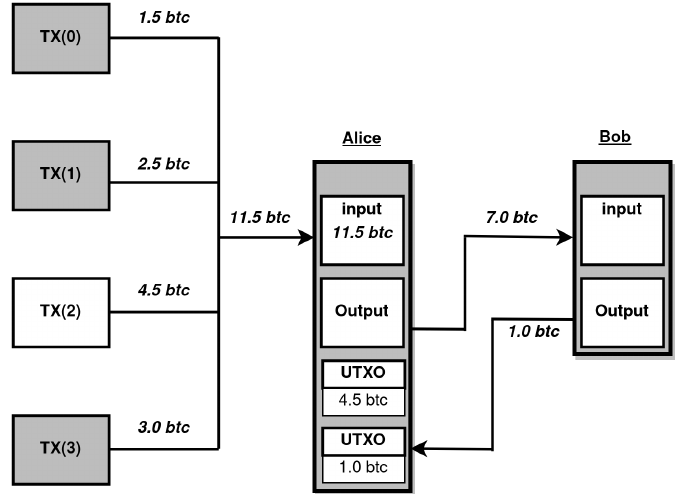
Figure 2. An example of Unspent Transaction Output (UTXO) where Alice sends 7 bitcoins to